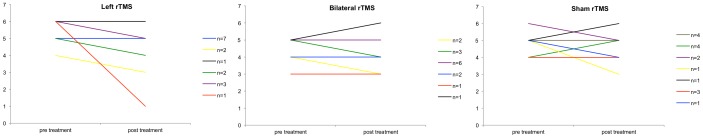
Changes in PANSS hallucination scores.This figure illustrates the individual courses in hallucinations score. Each line represents how many subjects showed a specific change in hallucination score, separate for the three treatment groups.